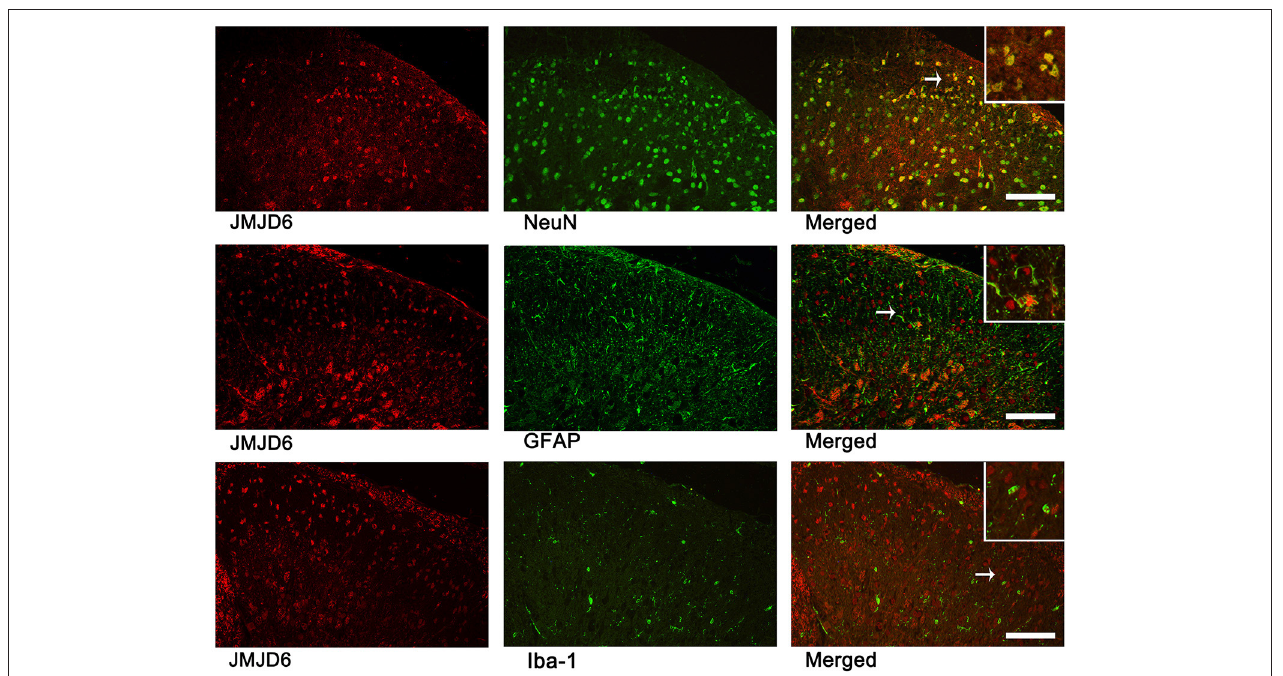
FIGURE 2 | JMJD6 is expressed in neurons at day 14 following CCI surgery. Arrows indicate the cells shown at high magnification in the insets. Double immunofluorescence labeling was performed for JMJD6 (red) and NeuN (green), GFAP (green), and Iba1 (green). Scale bars = 100 µ m.